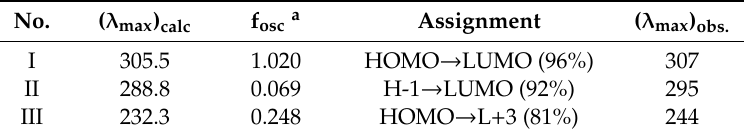
Table 5. Assignment of the electronic spectra of 2 .